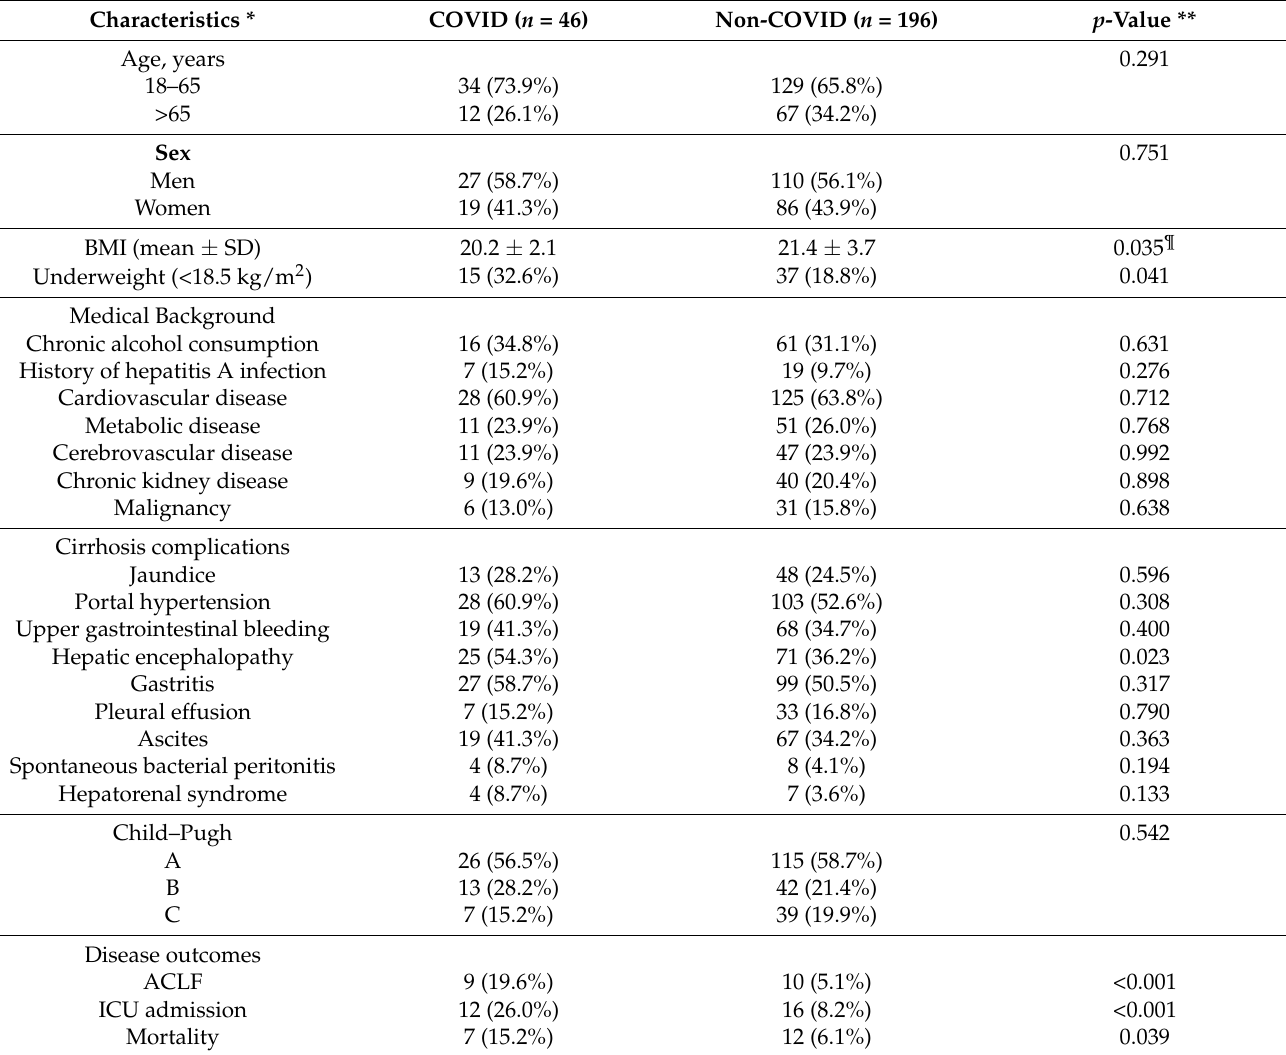
Table 1. Characteristics of study cohort compared with non-COVID patients with